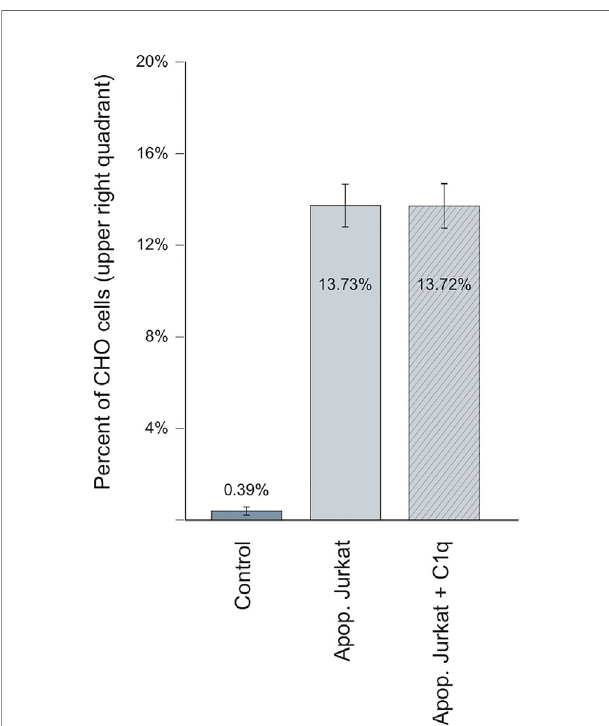
FIGURE 10 | C1q is not implicated in LRP1-dependent adsorption of Jurkat apoptotic cells Flow cytometry analysis of CHO cells stably expressing full- length LRP1, incubated with apoptotic Jurkat cells in the presence (dashed) or absence (plain) of C1q. Histograms representing the percentage of CHO- associated Jurkat cells from 4 independent